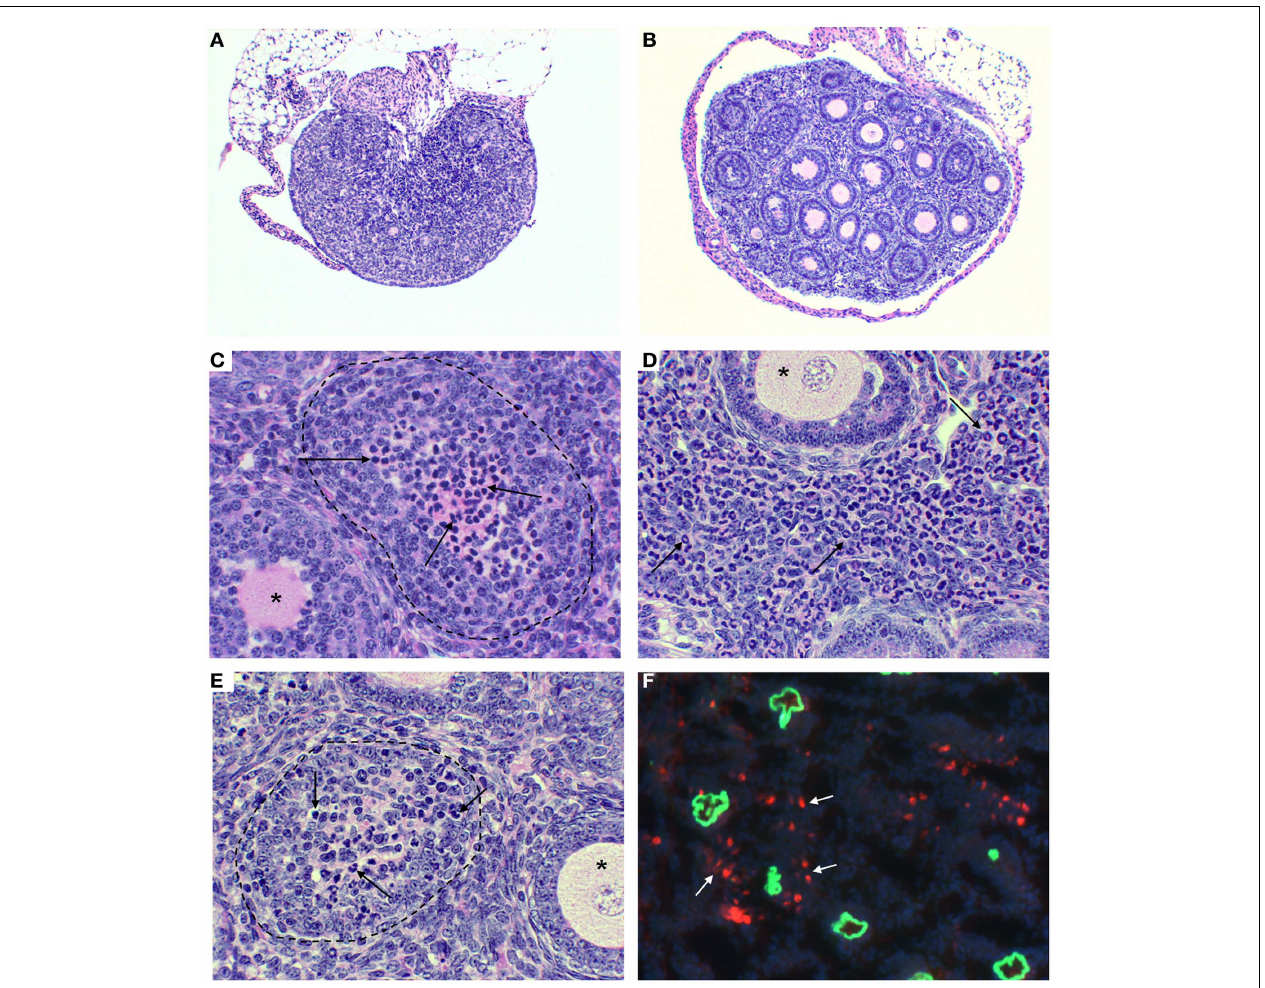
inflammatory cells while the asterisks (C–E) indicate normal ovarian follicles. (D) , Inflammatory cells also infiltrate the ovarian interstitium (arrows). In (F) , Immunofluorescence detection of mouse IgG (green fluorescence represents zona pellucida-bound ZP3 mAb); and NKG2D + NK cells (red fluorescence) detectable outside and inside the zona pellucida (white arrows). DAPI (nuclear blue staining). Magnification [ (A,B) : 50 × ; (C–F) : 400 × ]. Hematolyxin and eosin stain (A–E) . [Reproduced from Rival et al. (45), J. Immunol . 191,